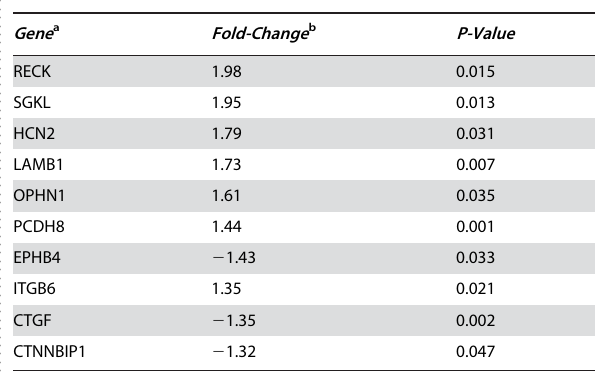
a For gene names, refer to Table 3 b Negative fold changes correspond to down-regulation of gene expression in cocaine tissue relative to control tissue. doi:10.1371/journal.pone.0001187.t004 .